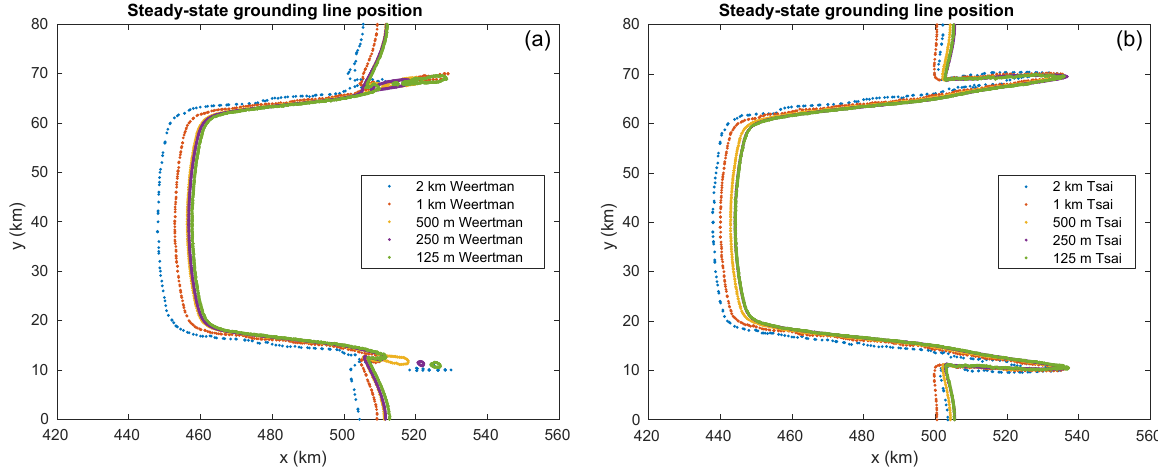
Figure 3. Steady-state grounding line positions for the Weertman (a) and Tsai (b) friction law for the 2km (blue), 1km (red), 500m (yellow), 250m (purple), and 125m (green) mesh resolutions. Note that the Tsai friction grounding lines for the 250 and 125m resolution meshes are